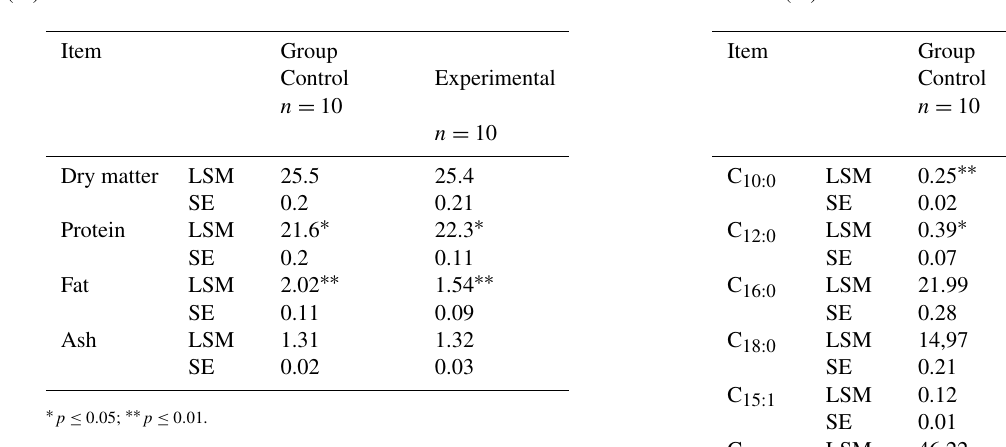
Table 5. Chemical composition of goat kid muscle tissue by percent (%).